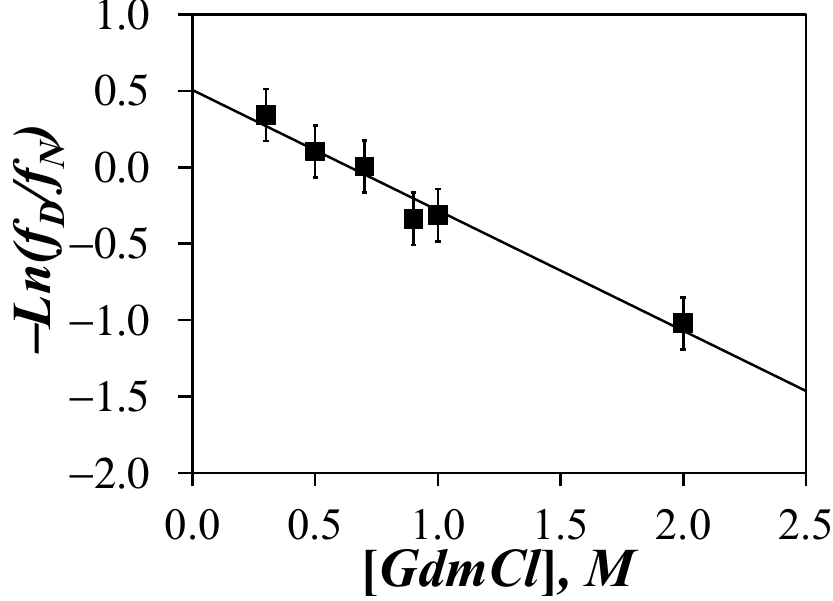
Figure 6. Plot of − Ln ( f D / f N ) as a function of GdHCl concentration where f D and f N are calculated from the < N blob > values obtained for Py-P L GA trend shown in Figure 4C. Application of the LEM using < N blob > as an experimental observable to measure ∆ unfold G (DMF) for the unfolding of P L GA in DMF upon the addition of GdHCl resulted in a surprisingly good linearity between − Ln ( f D / f N ) and the GdHCl concentration in Figure 6. The ∆ unfold G (DMF) value of 1.3 ( ± 0.2) kJ · mol − 1 obtained from the y -intercept of the plot was more than one order of magnitude lower than the ∆ unfold G (H 2 O) values reported for the unfolding of globular proteins in water [29]. Such a difference between ∆ ∆ unfold G (DMF) and unfold G (H 2 O) was to be expected. Beside the fact that DMF was